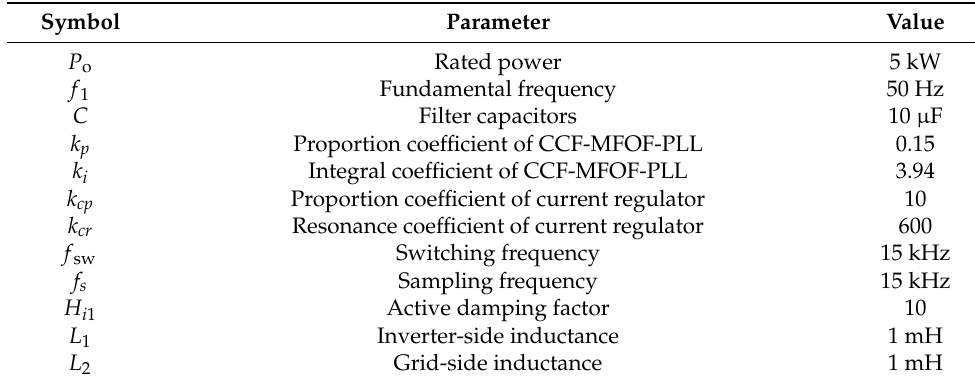
Table 1. Relevant parameters of the CCF-MFOF-PLL and